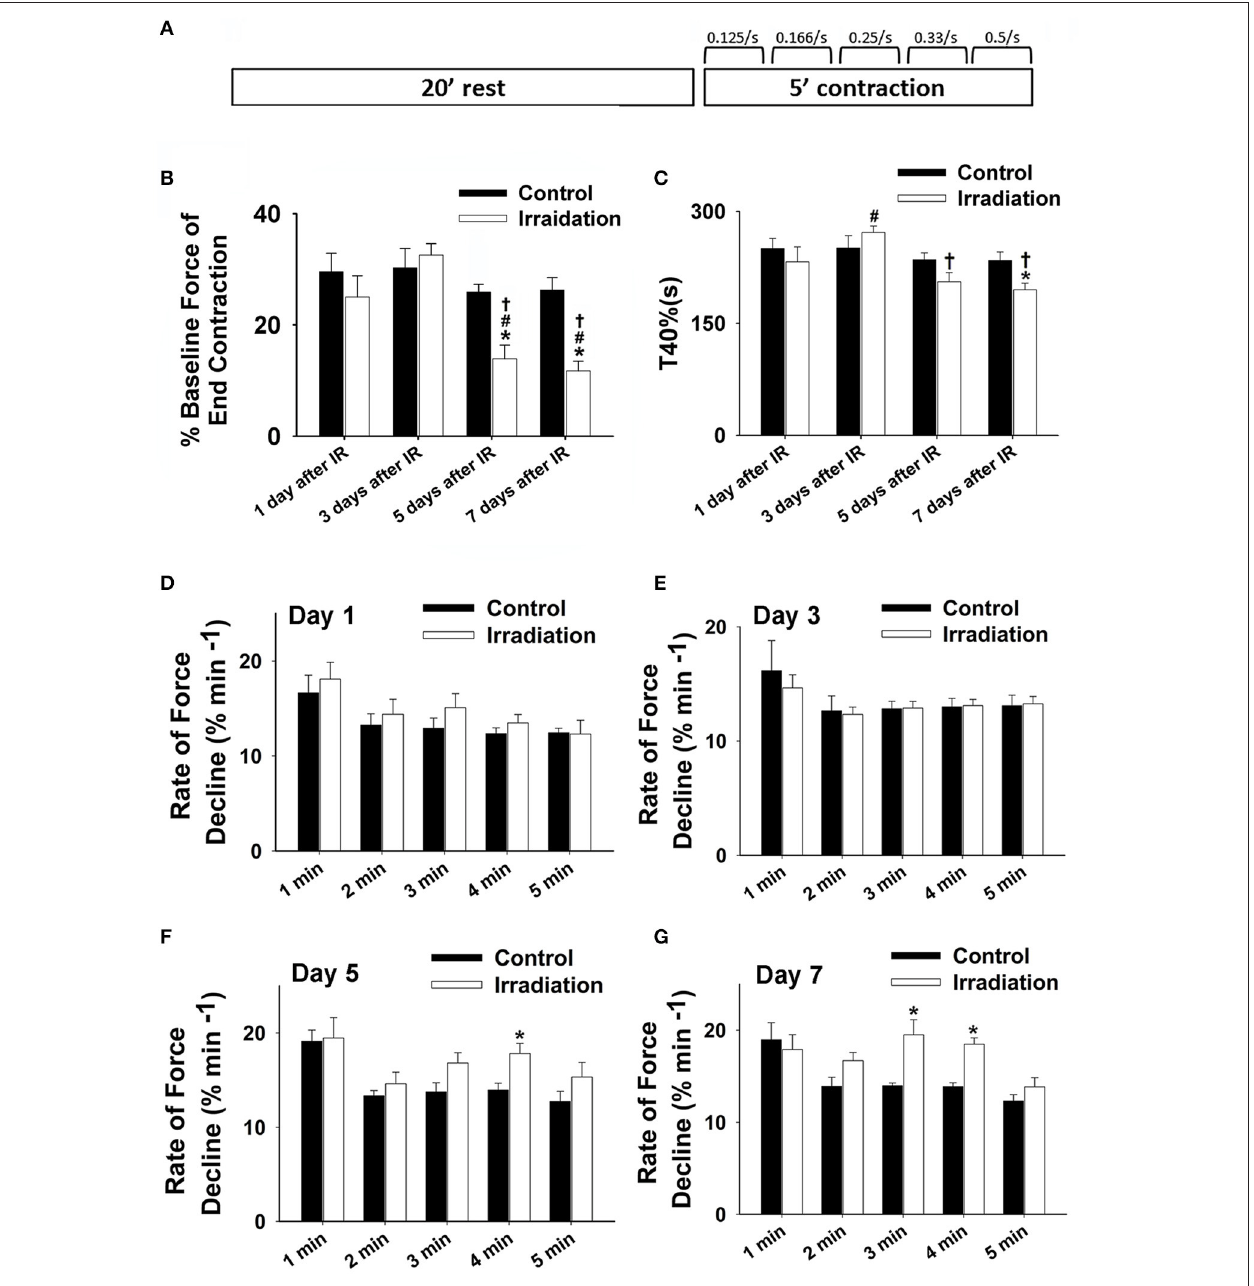
FIGURE 1 | (A) Schematic showing muscle function protocol. (B) Grouped data showing the percentage of baseline force at the end contraction (300 s) in irradiation vs. control group on the 1st, 3rd, 5th, and 7th days after IR ( n ≥ 6 for all treatment groups). (C) Grouped data of T40% (s) in irradiation vs. control group on the 1st, 3rd, 5th, and 7th days after IR ( n ≥ 6 for all treatment groups). (D–F) Grouped data showing the rates of force reduction during the 5-min contractile period from the initial force (% min − 1 ) in irradiation vs. control group on day 1 (D) , 3 (E) , 5 (F) , and 7 (G) after IR ( n ≥ 6 for all treatment groups). *Significant difference from control at the same day/time point; # Significant difference from 1 day after IR within the same treatment; † Significant difference from 3 days after IR within the same treatment. Sig. (2-tail); p < 0.05.